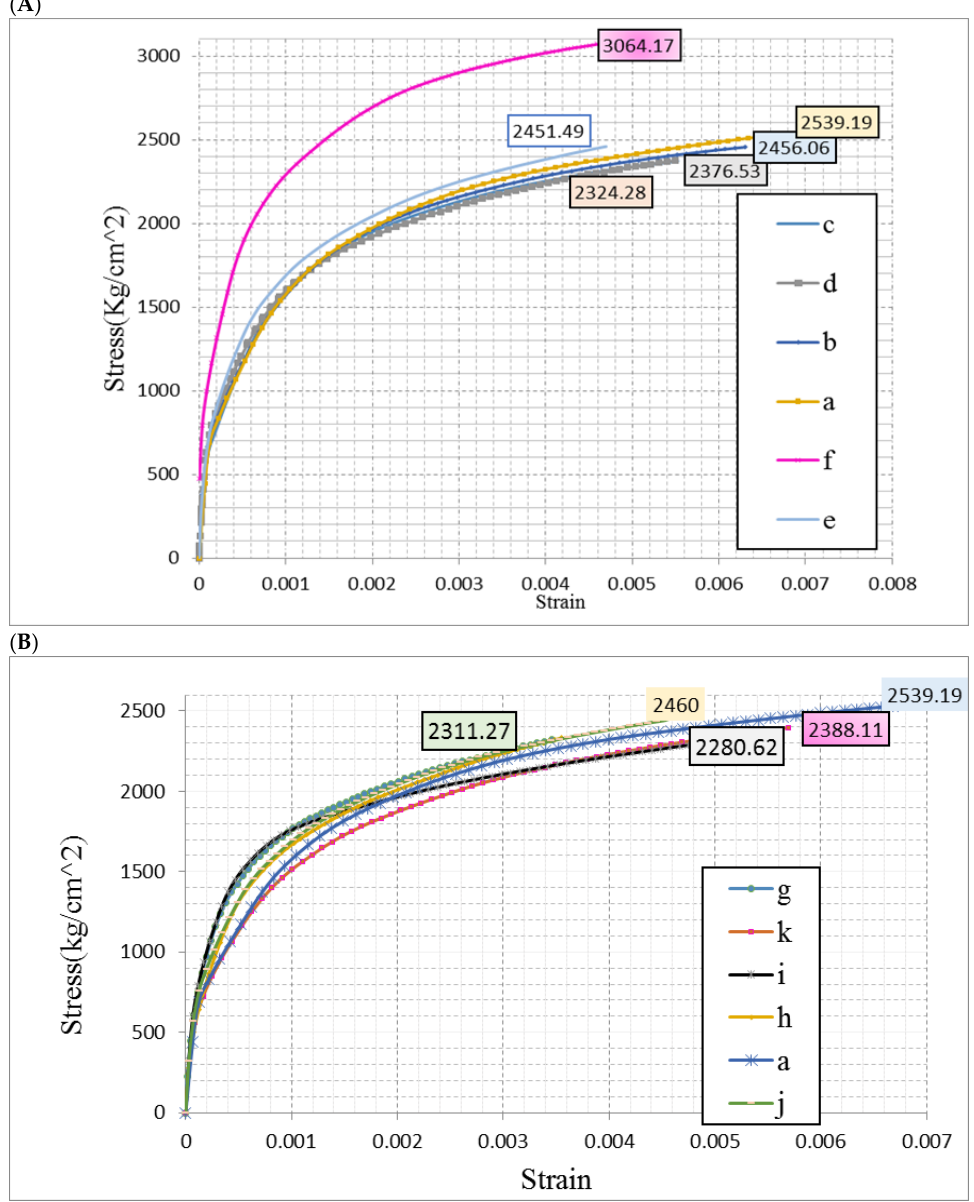
Figure 33. Stress -strain curve for steel part of the specimen ( A ( for group (a) and ( B ) for group (b) . Figure 33. Stress-strain curve for steel part of the specimen ( A ) for group (a) and ( B ) for group